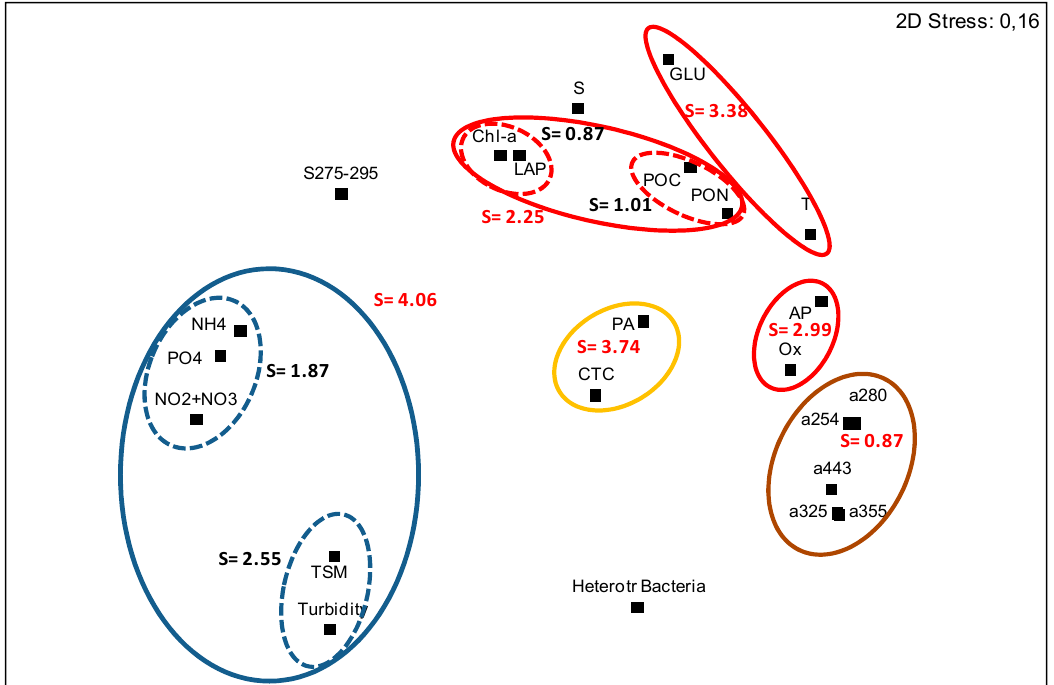
Figure 8. Multidimensional scaling (MDS) analysis of environmental and microbiological variables; the similarity (S) level among the variables is indicated.